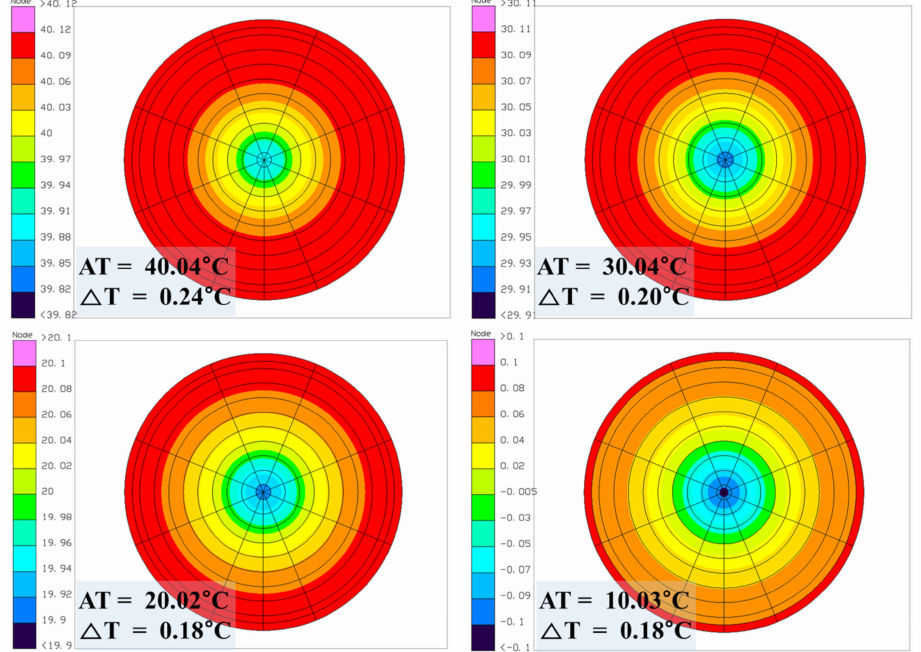
Figure 10. Temperature distribution on BB surface in cooling range at one heat pipe failure condition in the worst hot case; AT: average temperature of BB surface; ∆ T: temperature gradient on BB